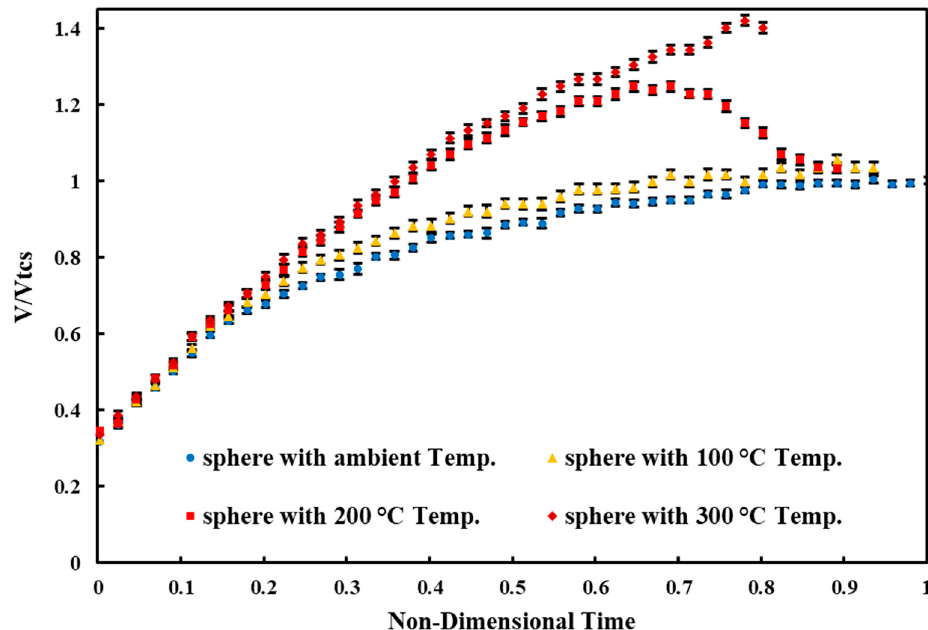
Figure 5. The dimensionless velocity versus the dimensionless time for the sphere at different temperatures where Vtcs is terminal velocity of cold sphere.